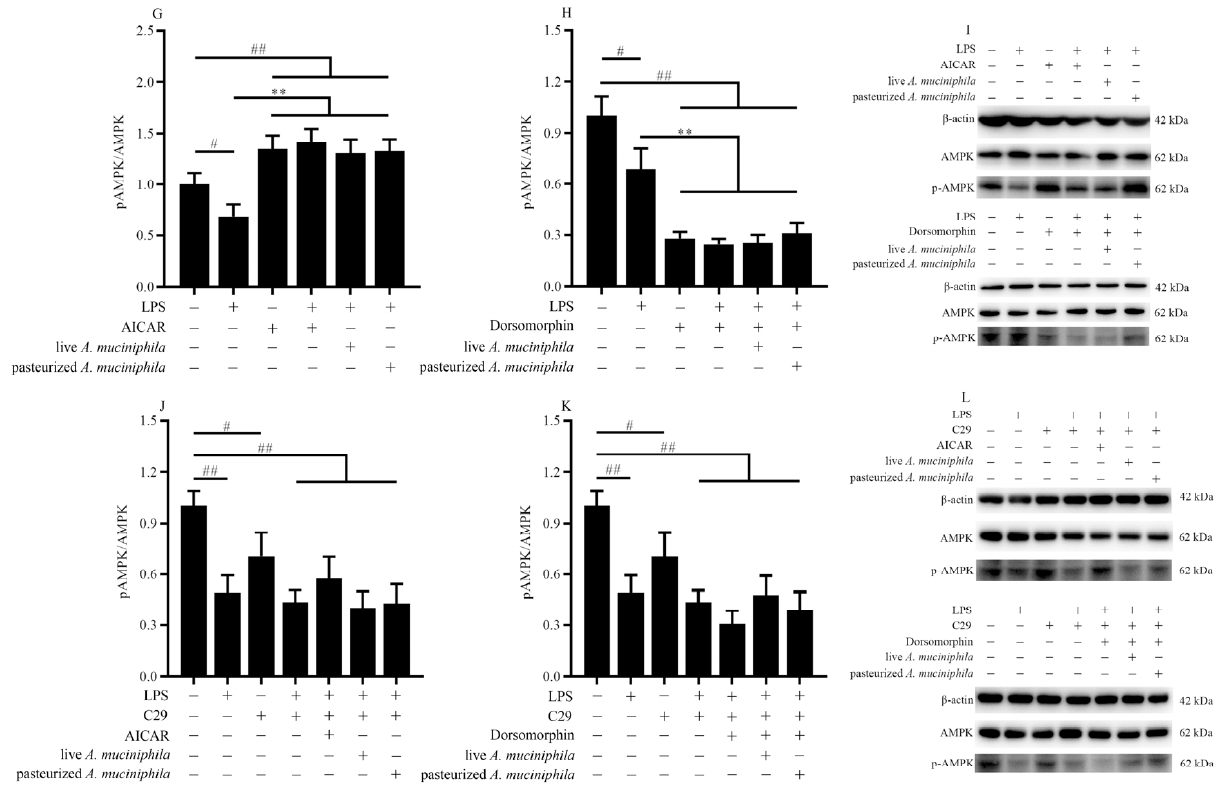
Figure 4. The activation of AMPK was mediated by A. muciniphila through TLR2 in LPS Caco-2 cells. ( A ( a – c )) The TEM images of A. muciniphila attaching to Caco-2 cells. The red arrows indicate A. muciniphila . The blue circles indicate cross-section between cells and A. muciniphila . Scale bars, 5 μ m. ( B , C , F ) The expression of TLR2, TLR4, ( D , E ) and activation of AMPK in Caco-2 cells treated with A. muciniphila . ( G – I ) The activation of AMPK in Caco-2 cells treated with A. muciniphila , AICAR, or dorsomorphin. ( J – L ) The activation of AMPK in Caco-2 cells treated with A. muciniphila , C29, AICAR, or dorsomorphin. ** p < 0.01, * p < 0.05, compared with LPS group; ## p < 0.01, # p < 0.05, compared with NC group. Data are expressed as mean ± S.D. ( n = 6). NC, control group. LPS, lipo- polysaccharide-damaged group. LA, live A. muciniphila . PA, pasteurized A. muciniphila . LAL, live